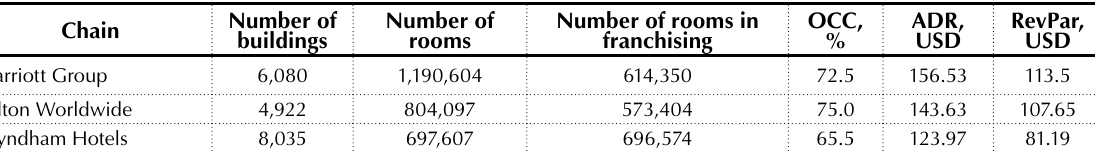
Table 1. Comparison of the main competitors according to the key indicators, 2016